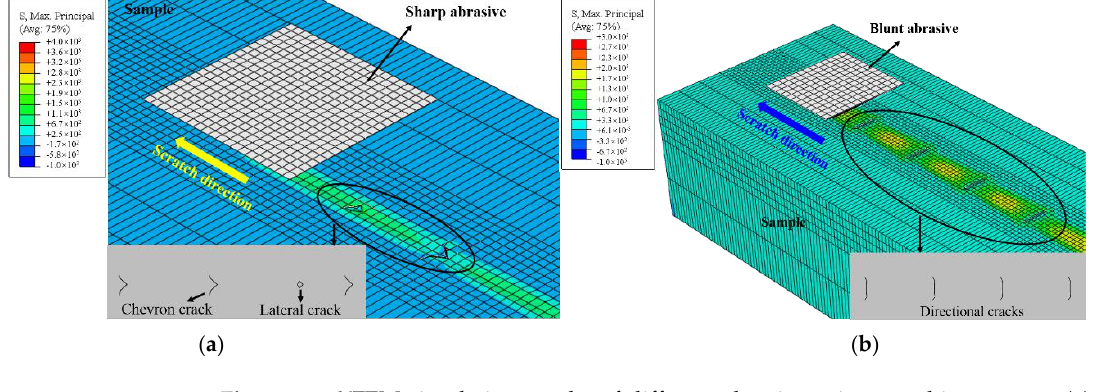
Figure 15. XFEM simulation results of different abrasive grits scratching quartz: ( a ) sharp grit, ( b ) blunt grit. The inserted figures show the enlarged view of the crack results.